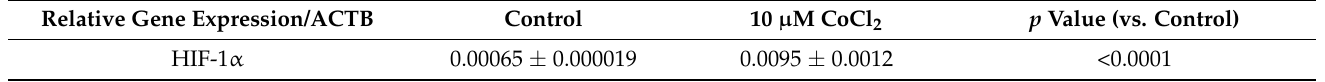
Table 4. Effect of CoCl 2 on HIF -1 α expression.